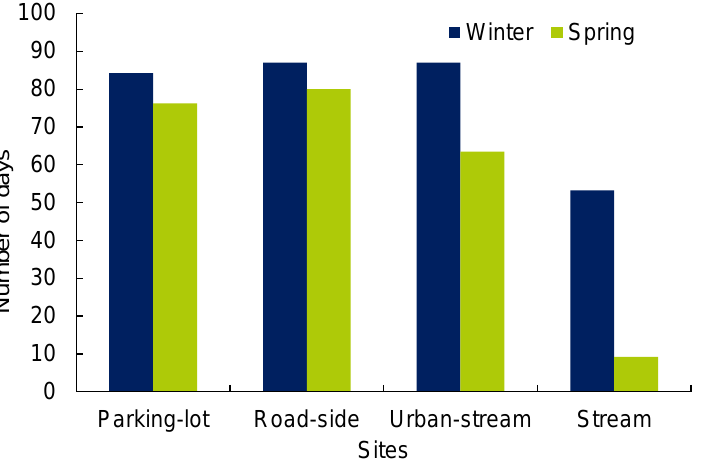
Figure 9. Distribution of a chronic exposure level (number of days) at different sites (i.e., parking-lot drain, roadside drain, urban-stream, and stream) for winter and spring seasons when salt concentrations are higher than USEPA threshold of 230 mg/L in ambient water.